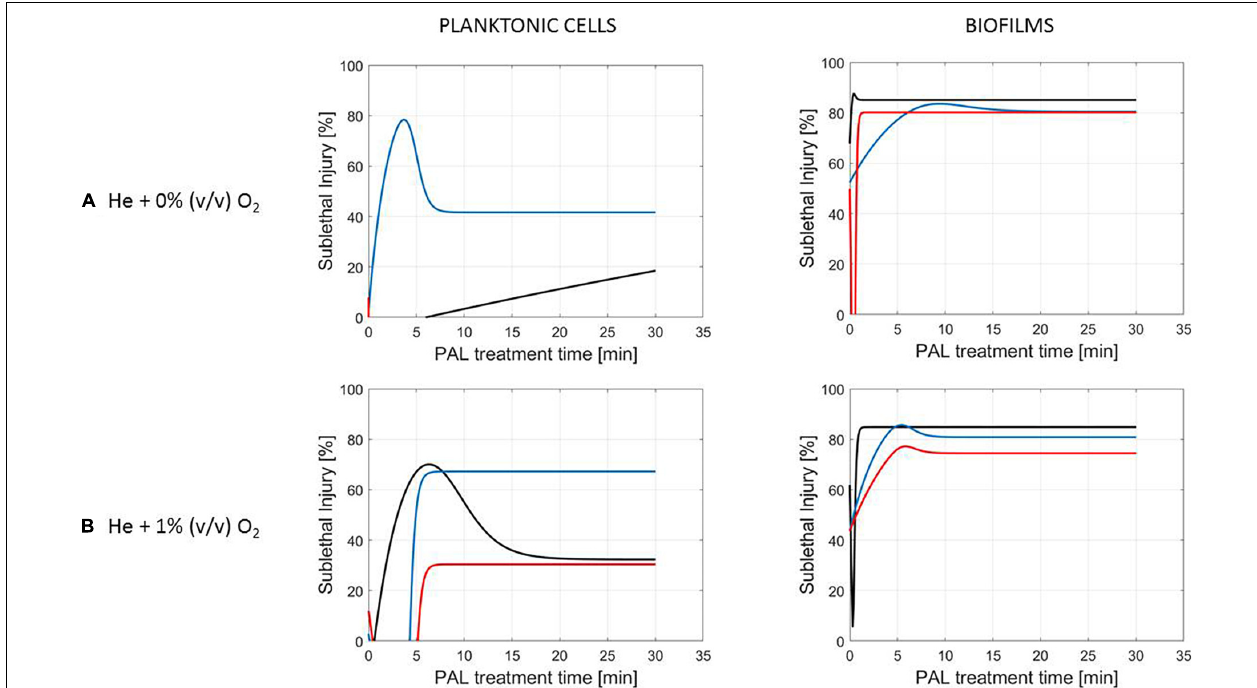
FIGURE 6 | Evolution with time of the sublethal injury (%) of S. Typhimurium planktonic cells and biofilms toward the plasma activated liquid treatment time. Plasma activated liquids were created using two different gas compositions (A) He + 0% (v/v) O 2 or (B) He + 1% (v/v) O 2 , and three different generation times (10, 20, and 30